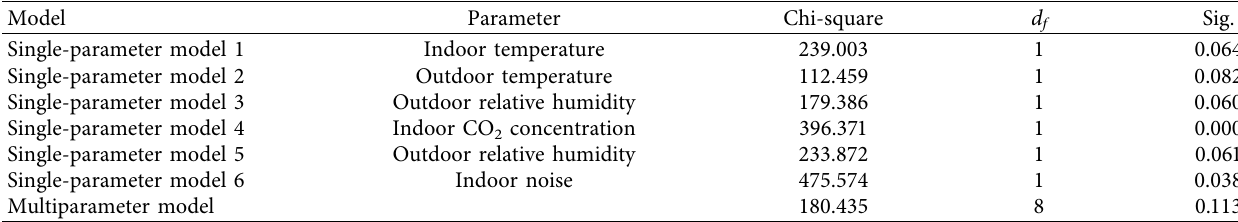
Table 6: Hosmer and Lemeshow tests with single and multiple parameters.